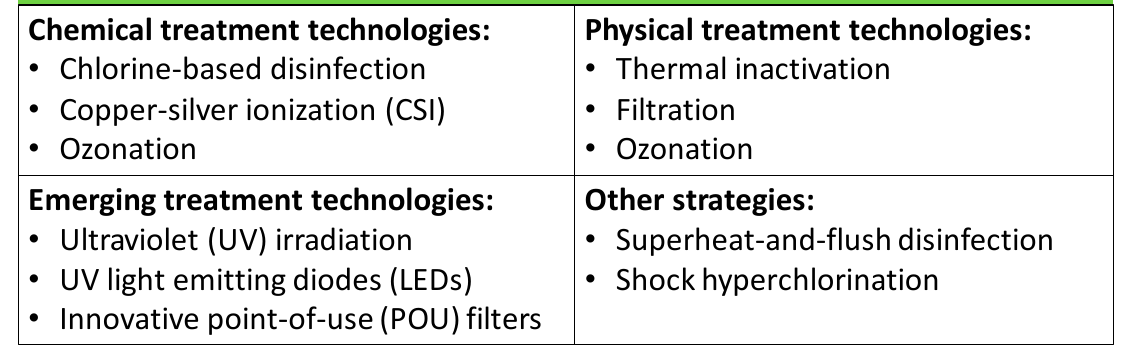
Figure 2. Current treatment technologies for control of Legionella in premise plumbing systems.